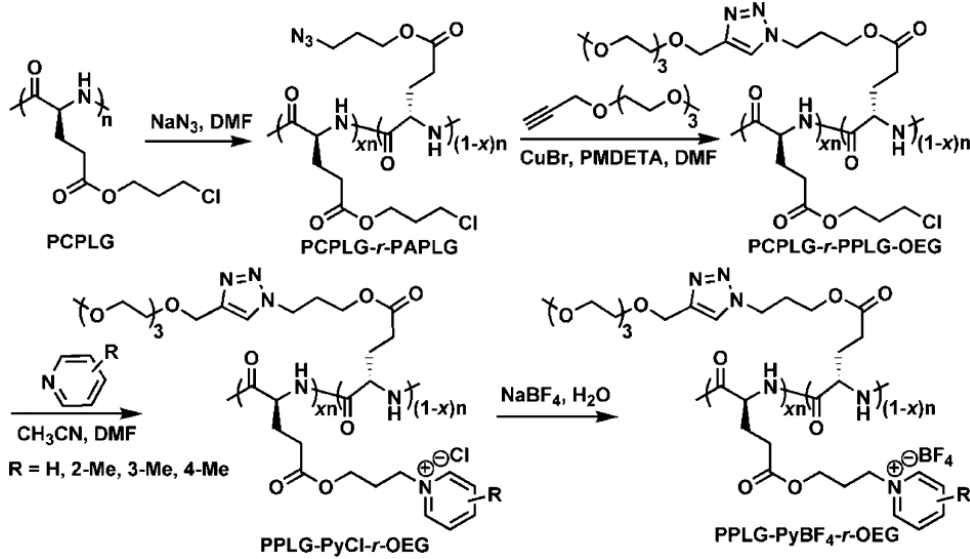
Figure 25. Synthetic Route of PPLG-PyBF 4 -r-OEG. Reproduced with permission from reference [118].